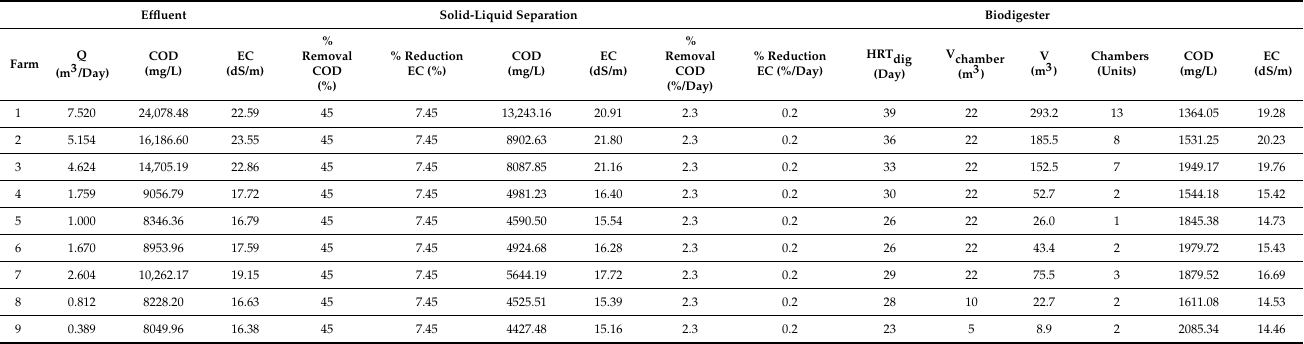
Table 5. Proposed NTSW design.